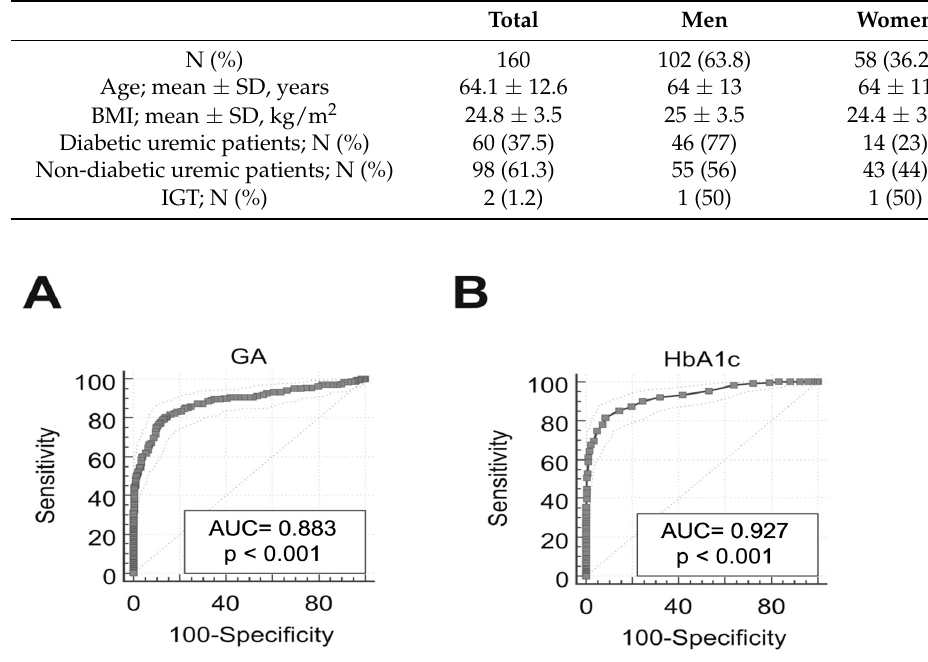
Figure 2. The ROC curves of GA (panel A ) and HbA1c (panel B ). Abbreviations: AUC, area under the curve; GA, glycated albumin; HbA1c, glycated hemoglobin; p , p -value; ROC, receiver operating characteristic.